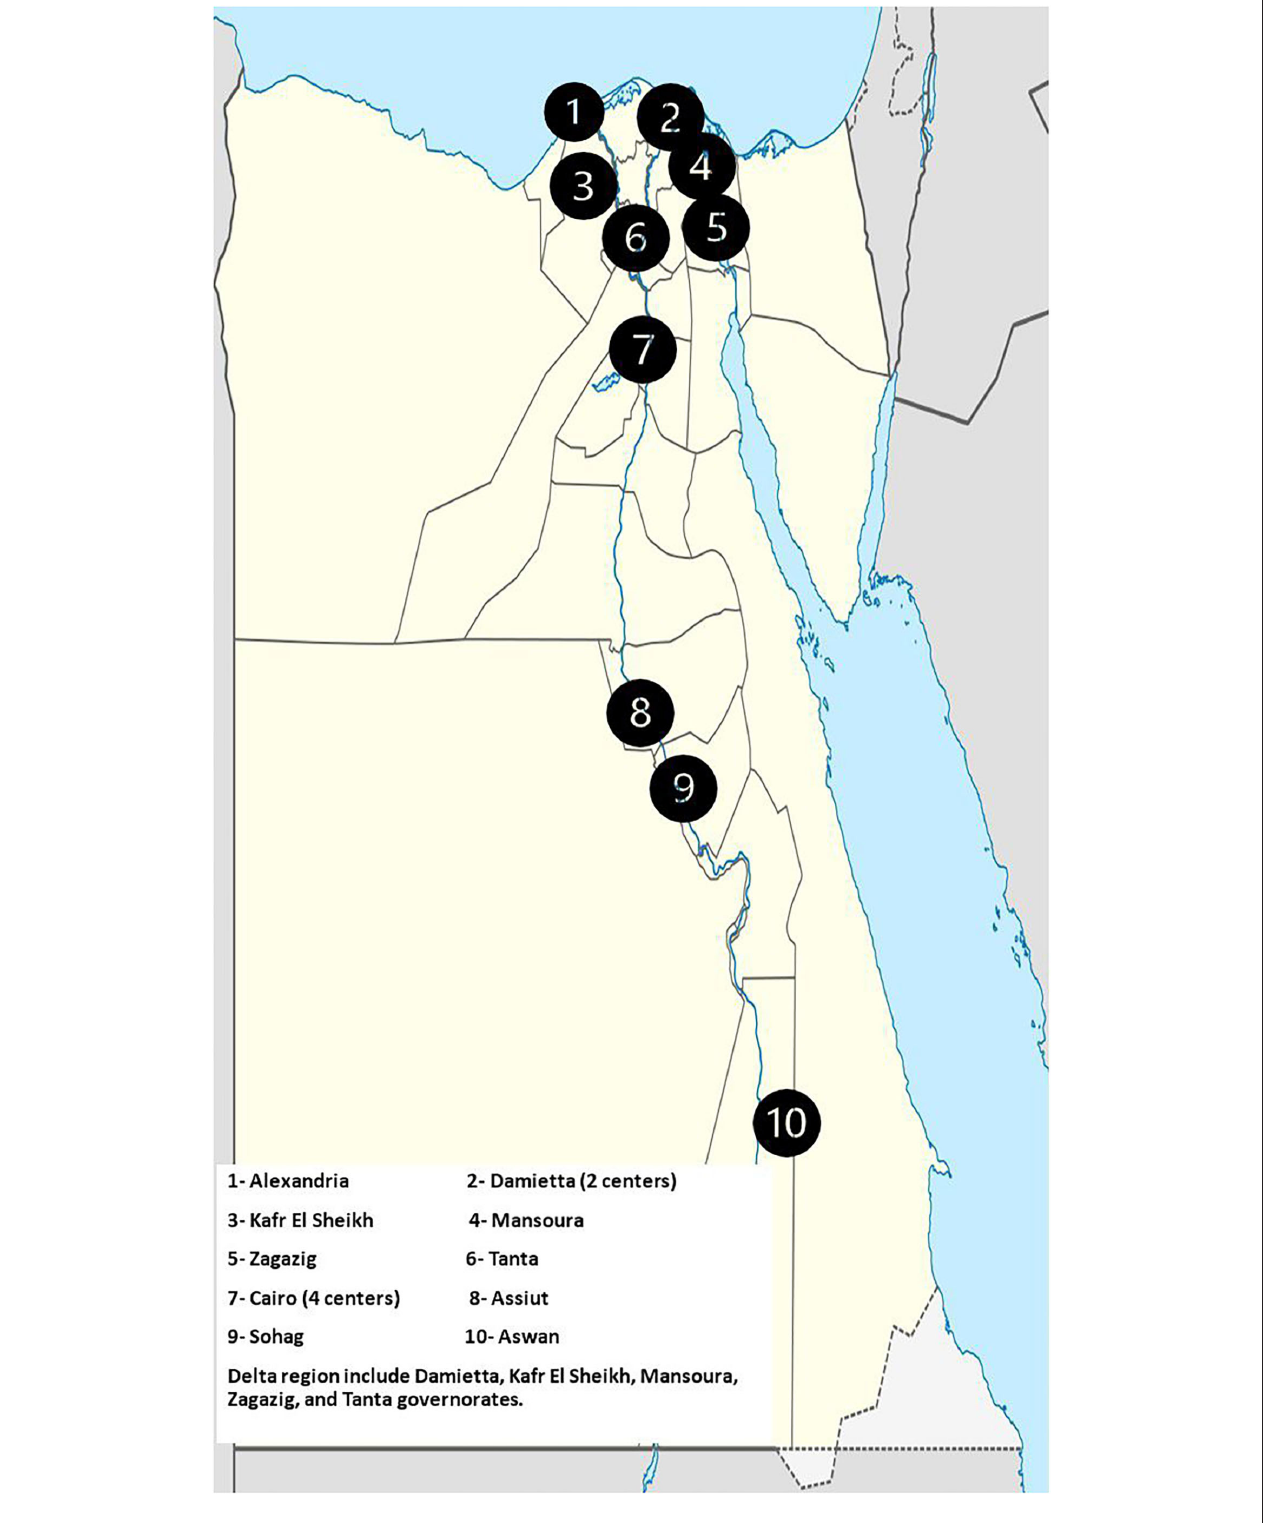
FIGURE 1 | Distribution of the participating centers in the study across Egypt.